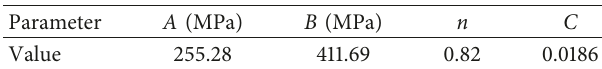
Table 5: Parameters of the Johnson-Cook model of 6005 Al